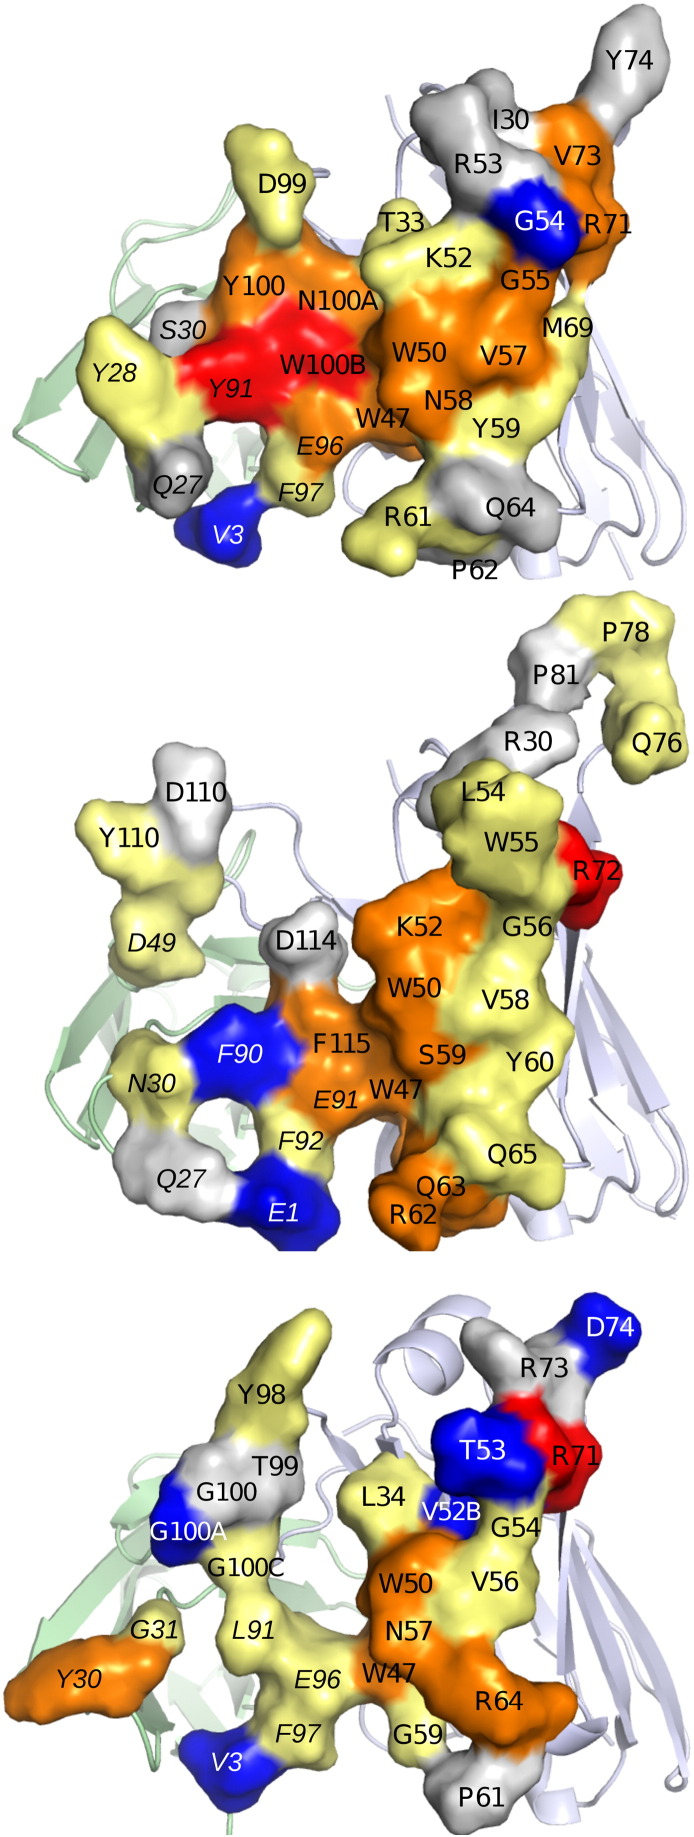
Antibody-gp120 interface residues of VRC01, VRC03, and VRC-PG04 antibodies. Antibody-binding interface is in surface representation with residues colored as follows: Red, ΔΔG > 2 kcal/mol; Orange, ΔΔG 1 to 2 kcal/mol; Yellow, ΔΔG 0.5 to 1 kcal/mol; Gray, ΔΔG − 0.5 to 0.5 kcal/mol; Blue, ΔΔG <− 0.5 kcal/mol. Light chain residue numbers are italicized. Antibody non-interfacial residues are in cartoon representation colored pale blue (heavy chain) and green (light chain).